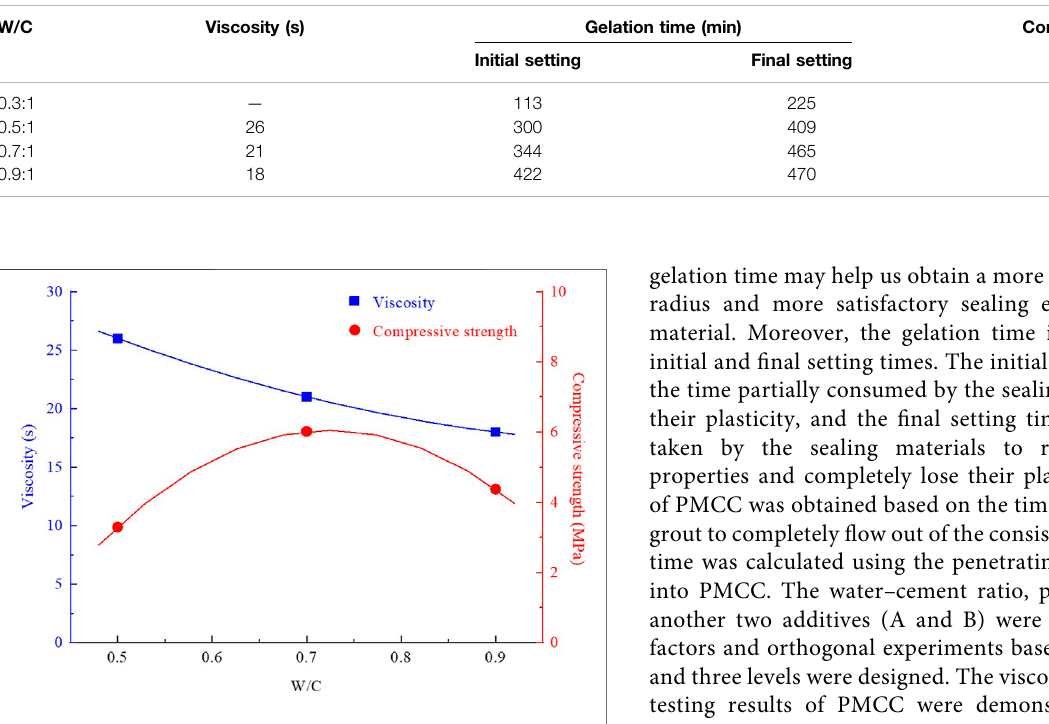
FIGURE 4 | Impact curve of water – cement ratio — viscosity – the compressive